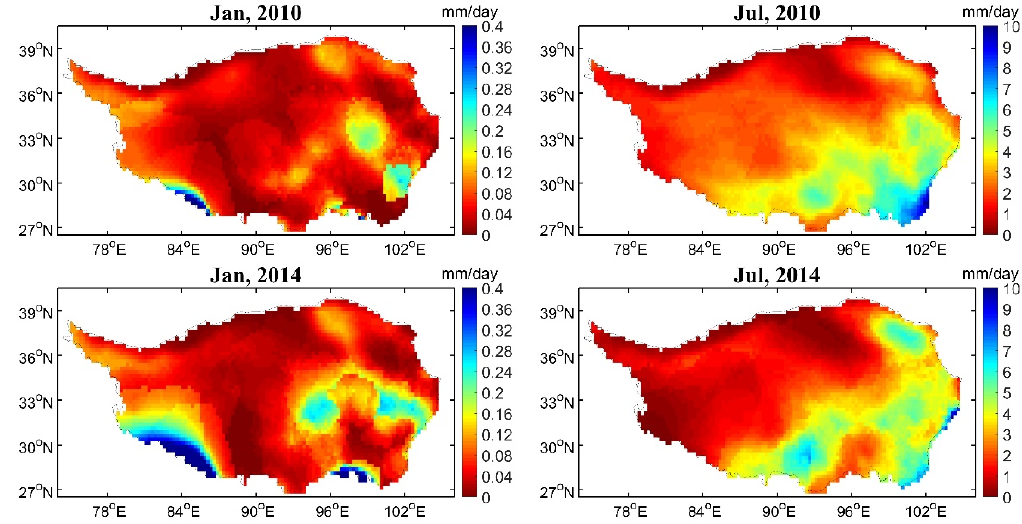
Figure 10. Spatial distribution of precipitation in January and July of 2010 and 2014.